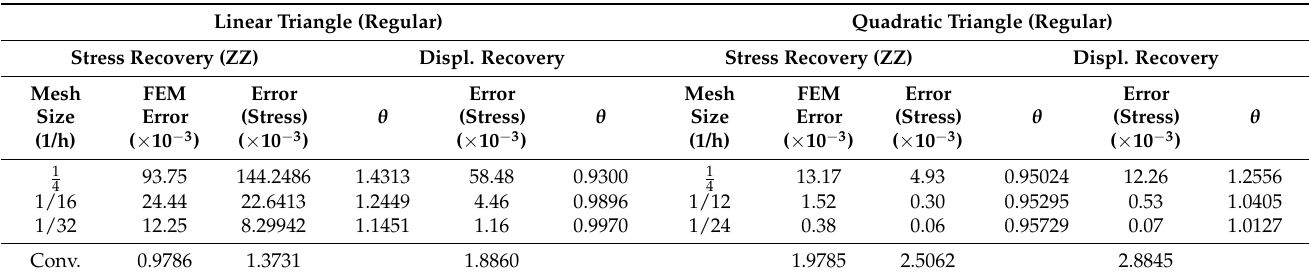
Table 5. Error in Stress (Energy Norm) and global effectivity ( θ ) in compressible elastic square plate example considering ZZ stress and displacement recovery techniques [20,24].